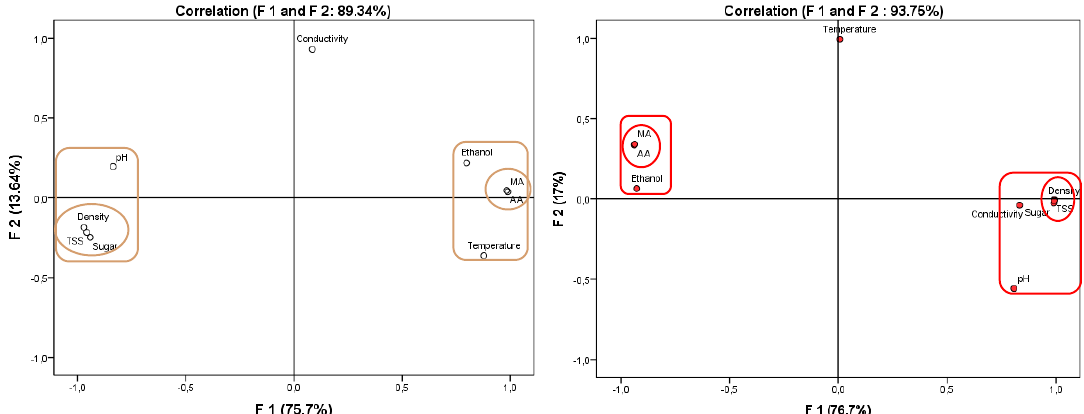
Figure 8. Correlation loadings plot of the two main factors resulting from principal component analysis of physicochemical parameters during fermentation of the white beer ( left ) and red beer ( right ) for ten days. Notes: Rectangles and circles show R 2 = 50% and 98%, respectively. Rotation method: Varimax with Kaiser normalization (KMO = 0.721 and 0.67, respectively, for white and red beer samples; p -value = 0.000). TSS: total soluble solids; AA: acetic acid; MA: malic acid. The geometrical figures indicate the correlation levels between physicochemical variables.